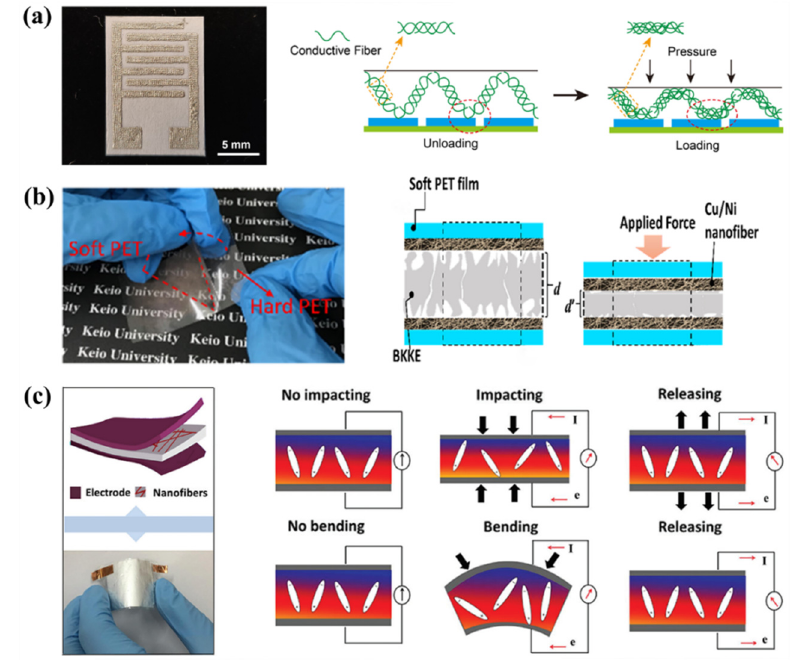
Figure 1. Picture and schematic diagrams of the pressure transduction mechanism. ( a ) Resistive type. Reproduced with permission from [38] , Copyright (2018), American Chemical Society. ( b ) Capacitive type. Reproduced with permission from [39] , Copyright (2019), American Chemical Society. ( c ) Piezoelectric type. Reproduced with permission from [40] , Copyright (2018), Royal Society of Chemistry.